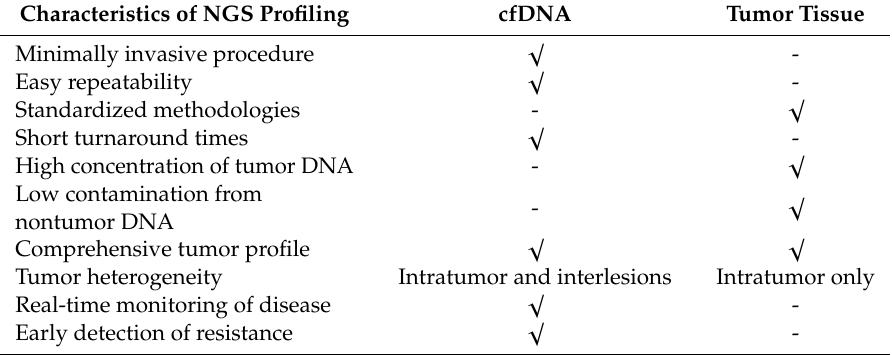
Table 1. Comparison between next generation sequencing (NGS)-based cfDNA and tumor tissue